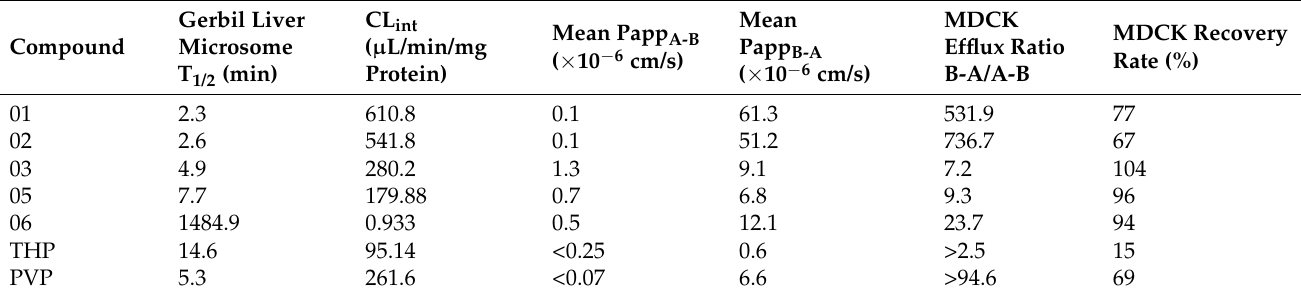
Table 2. In vitro ADME results. Analog 06 showed improved retention in the gerbil liver microsome assay as compared to its parent compound and the other analogs. PVP and the analogs except for 06 showed rapid clearance from microsomes, indicating that it could be rapidly metabolized in the